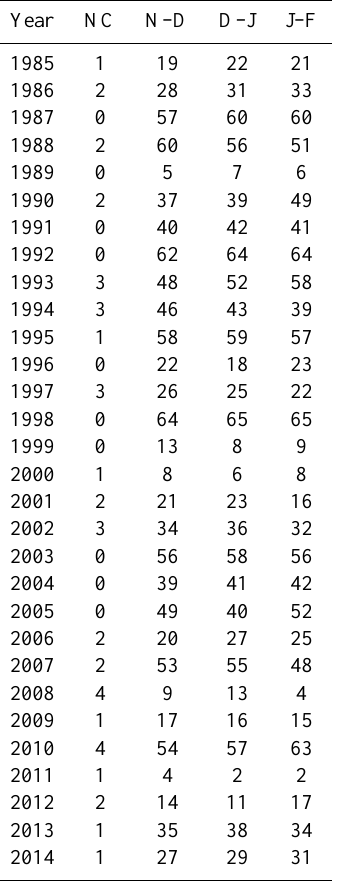
Table 4. Number of crevasses of the 12 tributaries of the Mamoré versus the rank of the Multivariate ENSO Index (MEI) for every year between 1985 and 2014. For moderate or strong ENSO events, MEI ranks from 1 to 13 would denote La Niña, while ranks from 54 to 66 would denote El Niño. NC is the number of crevasse splays.